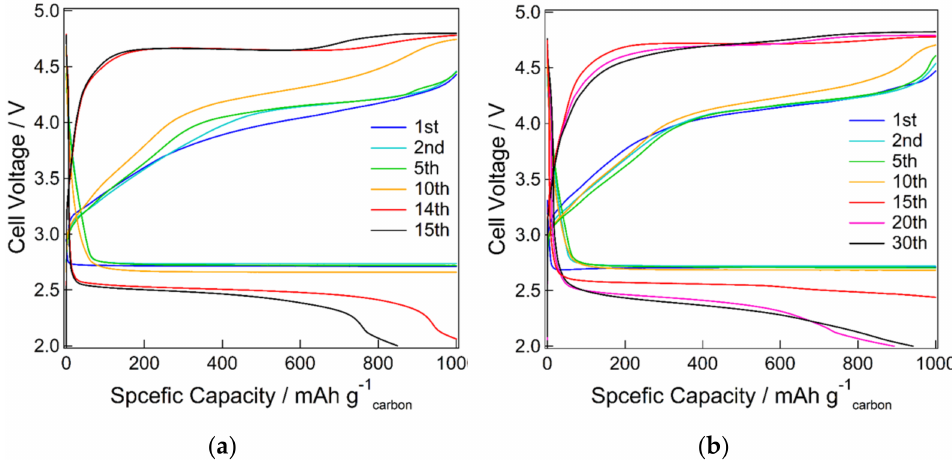
Figure 6. Cycling performance of Li-air batteries using ( a ) KB and ( b ) KB + VUV as cathodes at a limited capacity of 1000 mAh g -1 .